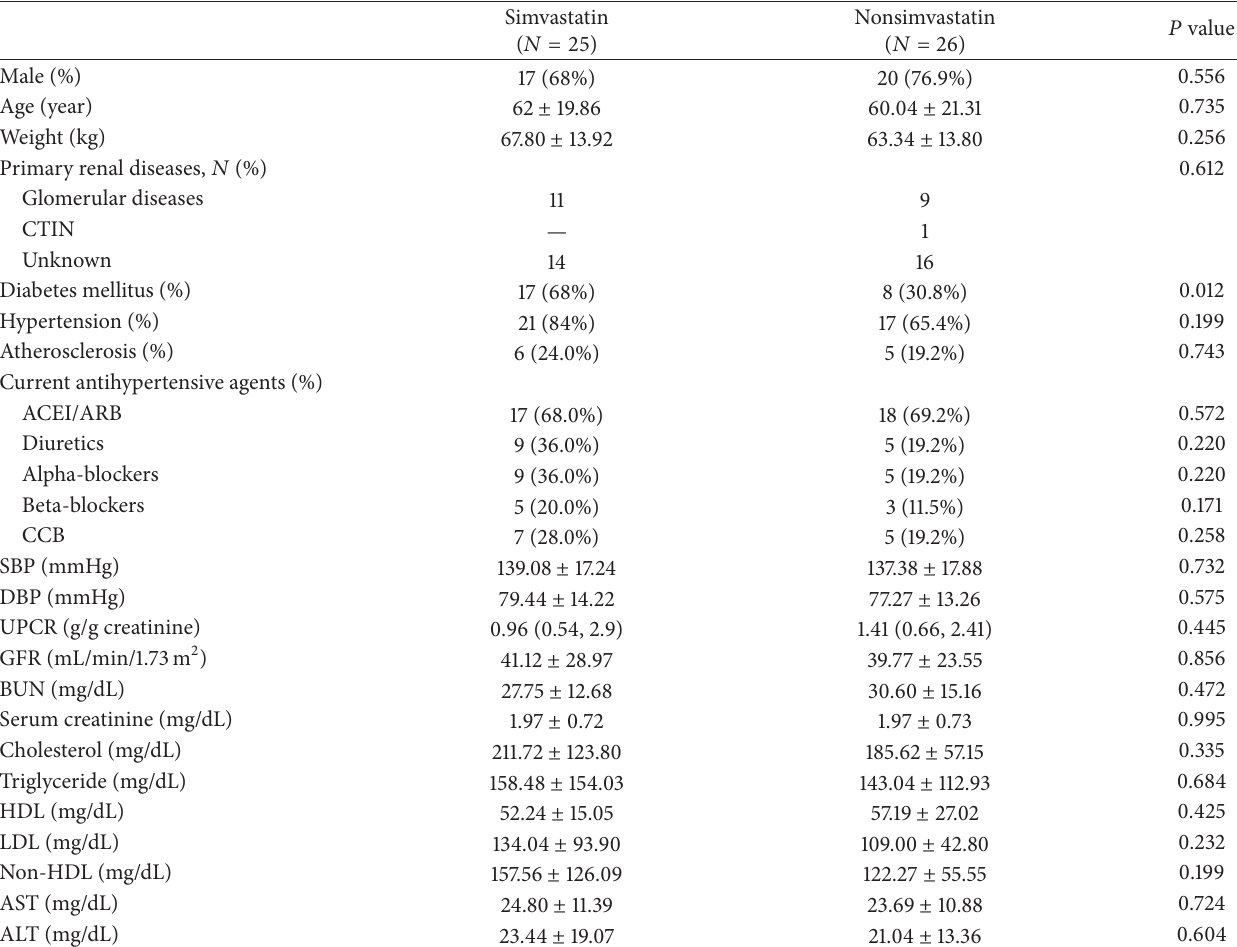
Table 1: Patients’ characteristics.